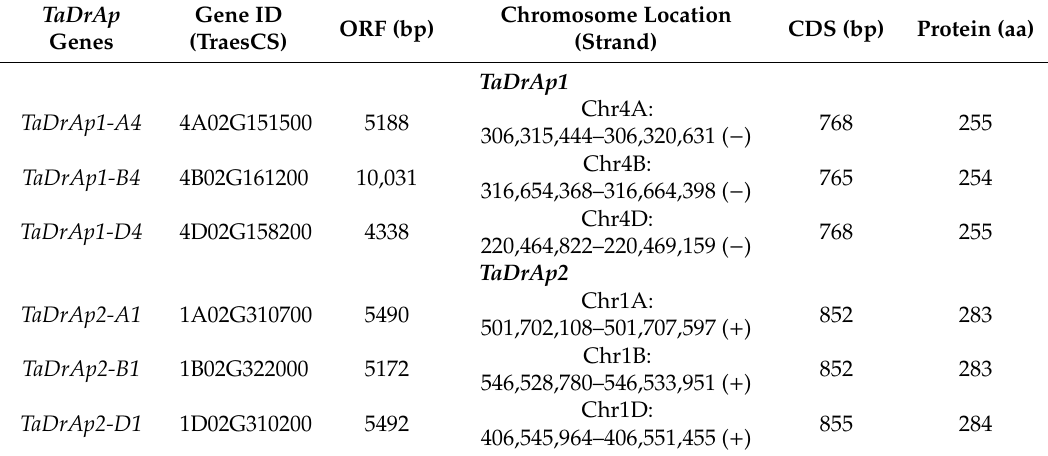
Table 1. Characteristics of the identified genes, TaDrAp1 and TaDrAp2 , encoding two down-regulator associated proteins, from the public database Gramene with sequence of cv. Chinese